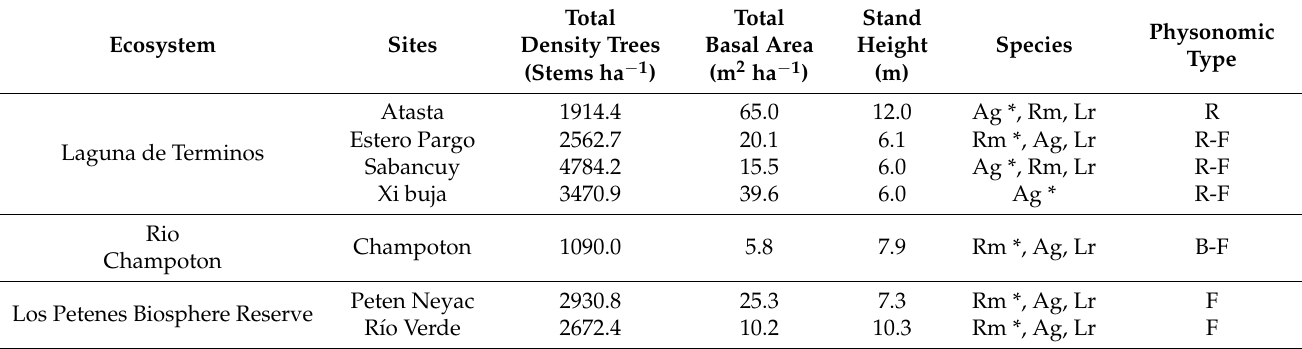
Table 3. Structural characteristics of mangrove forests of Campeche state,